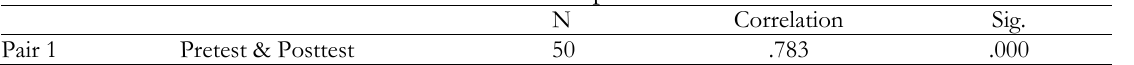
TABLE 4. Paired Samples Correlations